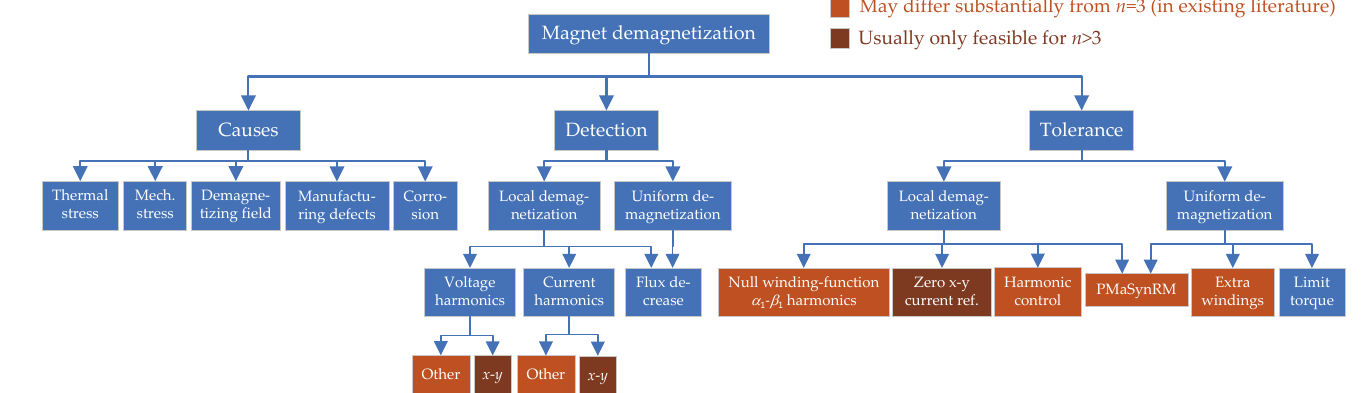
Figure 39. Causes, detection methods, and tolerance approaches for magnet demagnetization in multiphase